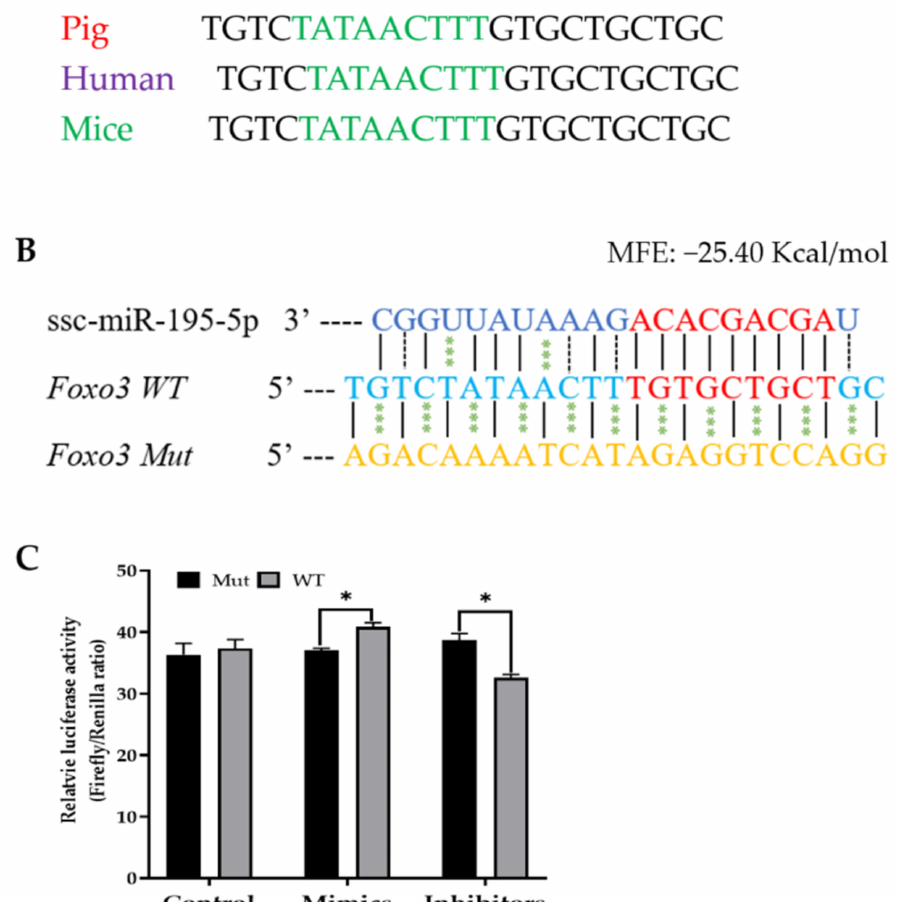
Figure 2. miR-195-5p transcriptionally regulates the expression of the Foxo3 gene via binding to its promoter region. ( A ) Comparison of miR-195-5p binding sites among pig, human and mice species. The TATA Box is highlighted in green. ( B ) The predicted binding site of miR-195-5p within the Foxo3 promoter and the mutated sequence of the predicted binding site for the luciferase. The seed sequence of miR-195-5p and the predicted binding site on the Foxo3 promoter are highlighted in red. ( C ) Dual-Luciferase assay was performed on the 293FT cell line. miRNA negative control, as well as miR-195-5p mimics and inhibitors were co-transfected with wild-type (WT) or mutant (Mut) luciferase vectors, respectively. Data are means ± SEM of three independent experiments. * indicates p < 0.05 when compared with